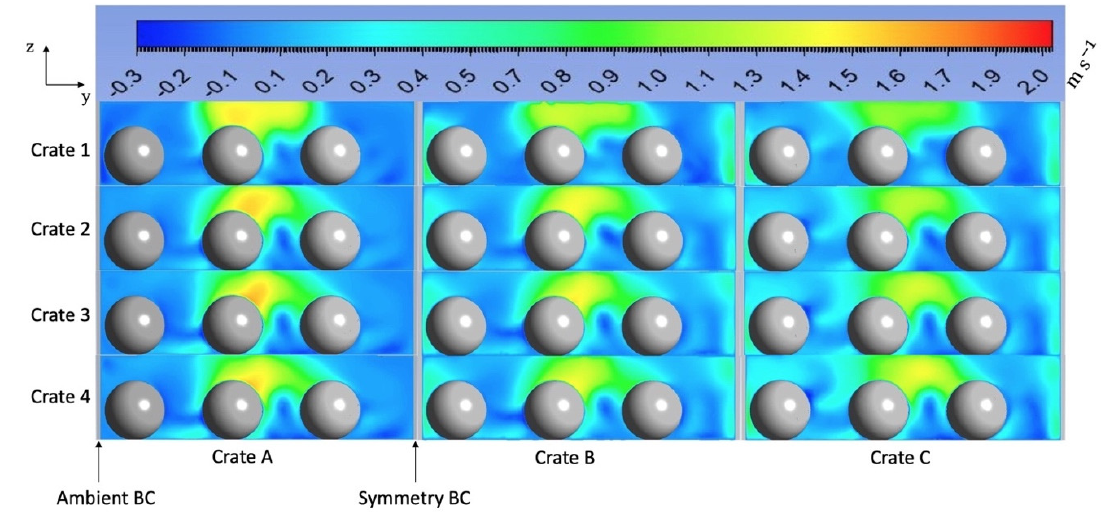
Figure 16. Illustration of the velocity fields at the middle plane of the crates for different crate designs at a pressure drop of 4.5 Pa.